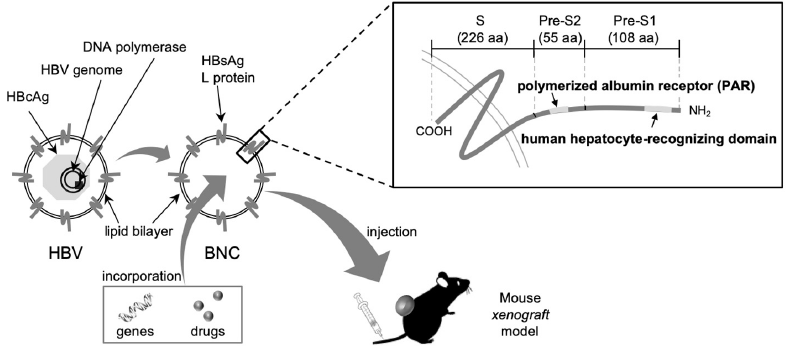
Figure 1. Structures of Bio-nanocapsule (BNC) and hepatitis B virus (HBV). HBV is composed of HBsAg embedded in lipid bilayer, HBcAg (HBV core antigen), DNA polymerase, and the HBV genome. Similarly, BNC is composed of HBsAg L proteins embedded in lipid bilayer. The L protein contains three domains, including the pre-S1 region containing a human hepatocyte-recognizing domain, the pre-S2 region with a polymerized albumin receptor (PAR) domain, and the S region with three transmembrane-spanning segments. The number of amino acids in each domain is indicated in parentheses. BNCs could be used for the in vivo pinpoint delivery of genes and drugs in mouse models via intravenous injection.